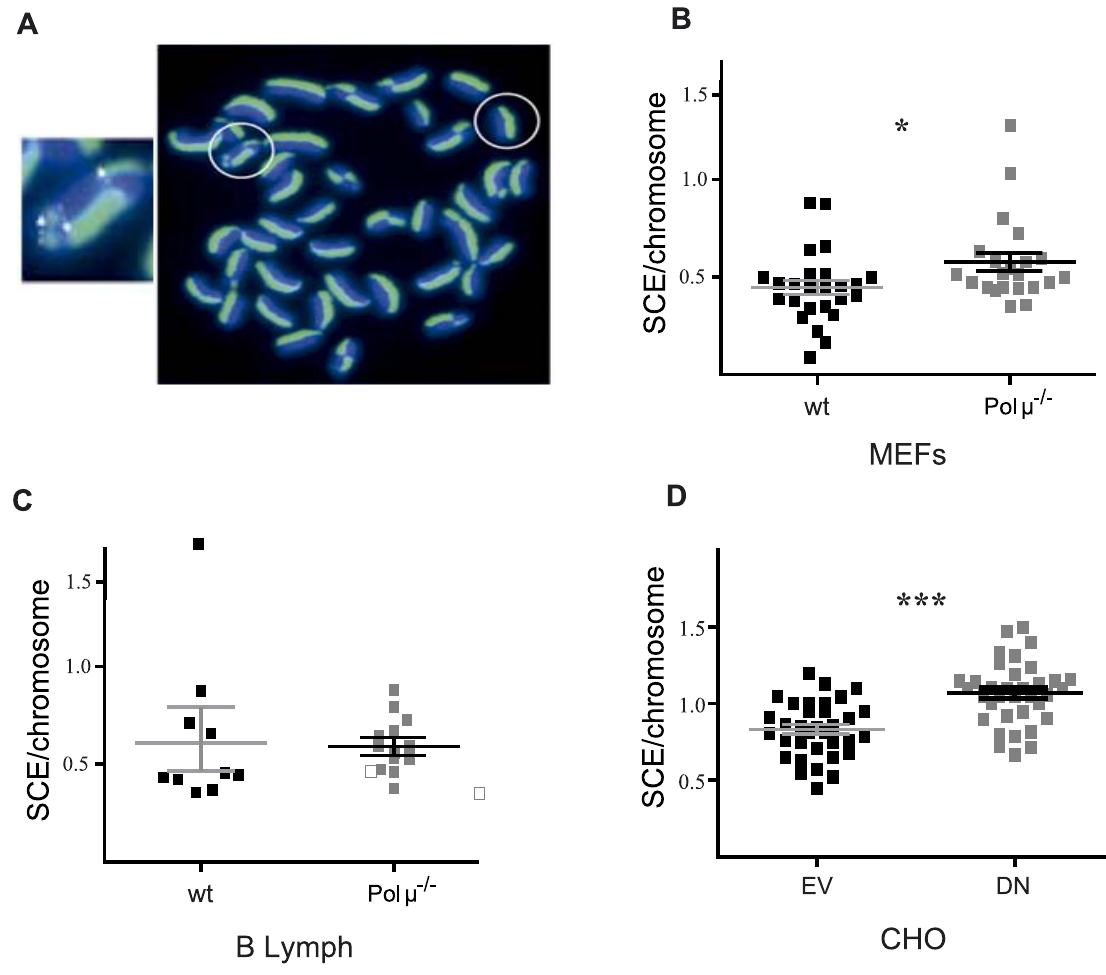
Figure 5. Evaluation of SCE in different cellular models of Pol m deficiency. ( A ) Illustrative example of sister chromatid exchange (SCE) between green chromatids (labeled by BrdU incorporation) and blue chromatids (DAPI stained). The enlarged image to the left shows a chromosome with 3 crossovers (indicated by arrows) in which green and blue are combined in the same chromatid. ( B–D ) Sister chromatid exchange (SCE) in three models of Pol m deficiency: ( B ) MEFs, ( C ) B lymphocytes and ( D ) CHO-KS4 cells expressing DN-Pol m ( D N); EV=empty vector.